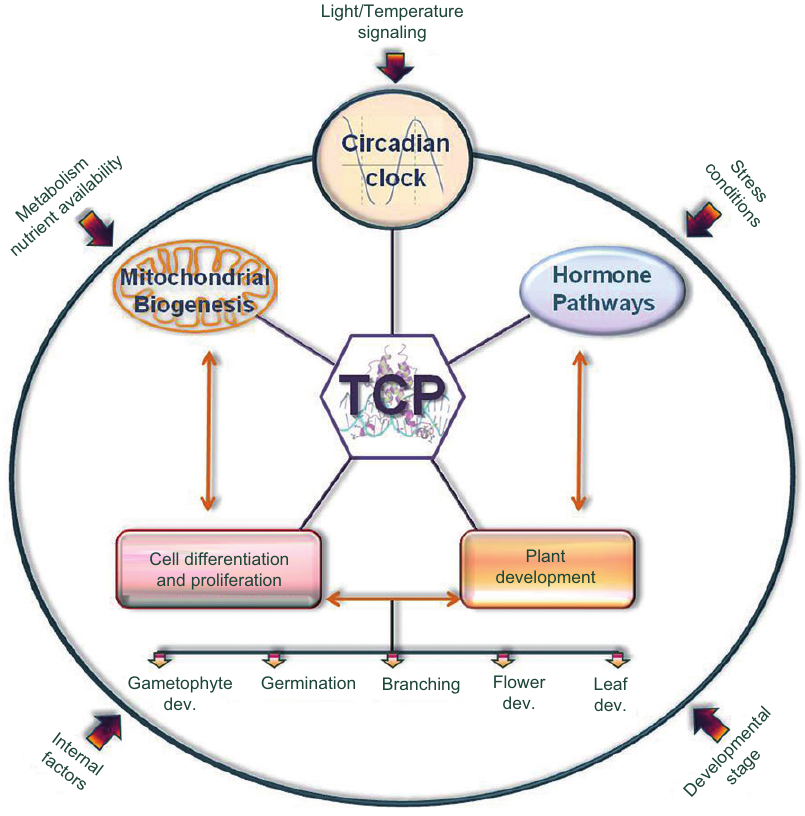
Figure 3 An integrated view of TCP protein